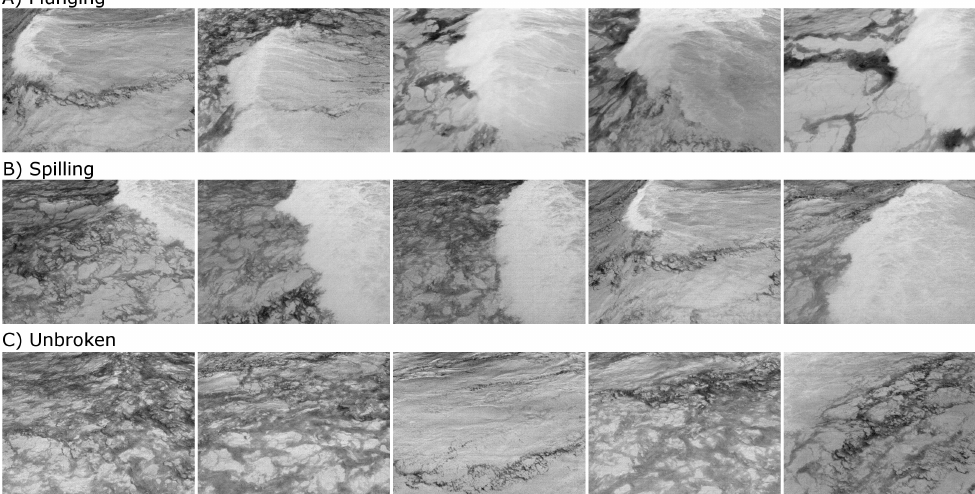
Figure 2. Example IR images of the three categorical wave classes: ( A ) plunging; ( B ) spilling; and ( C ) unbroken waves. The back face of a spilling breaker exhibits a unorganized texture, whereas that of a plunging breaker is characterized by an organized streak